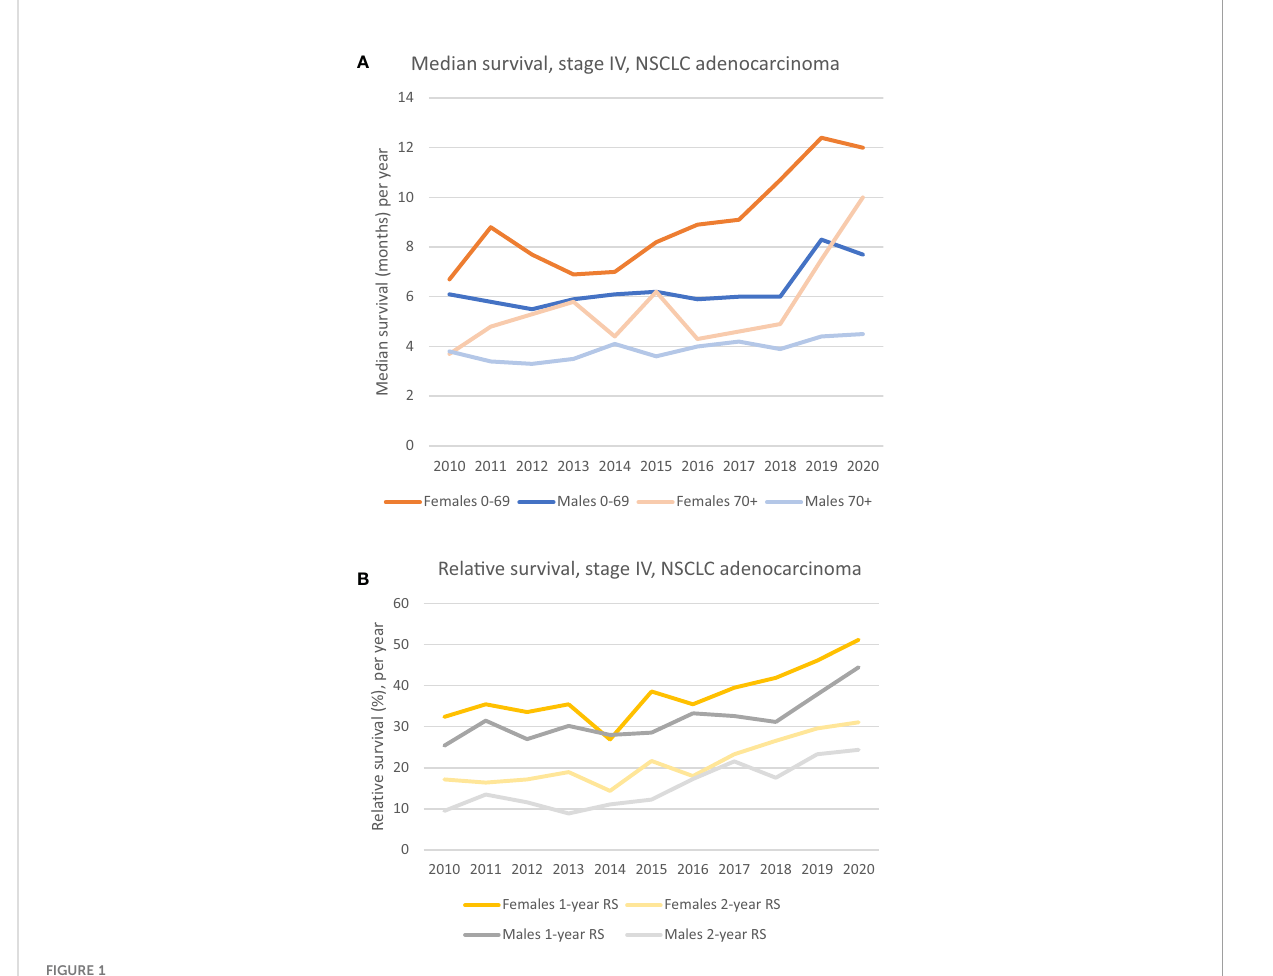
FIGURE 1 (A) Median survival of patients diagnosed in stage IV, NSCLC adenocarcinoma, by sex and age groups. Females aged 0-69 has had a steady increase since 2014, while the 70+ age group and the male 0-69 group show a marked increase in median survival from 2018. The median survival for males 70+ has been relatively poor and stable the whole period. (B) 1- and 2-year relative survival for patients diagnosed in stage IV, NSCLC adenocarcinoma. A clinically relevant improvement for both sexes can be seen. A unidirectional increase for females is seen from 2016, whilst it is seen from 2018 in